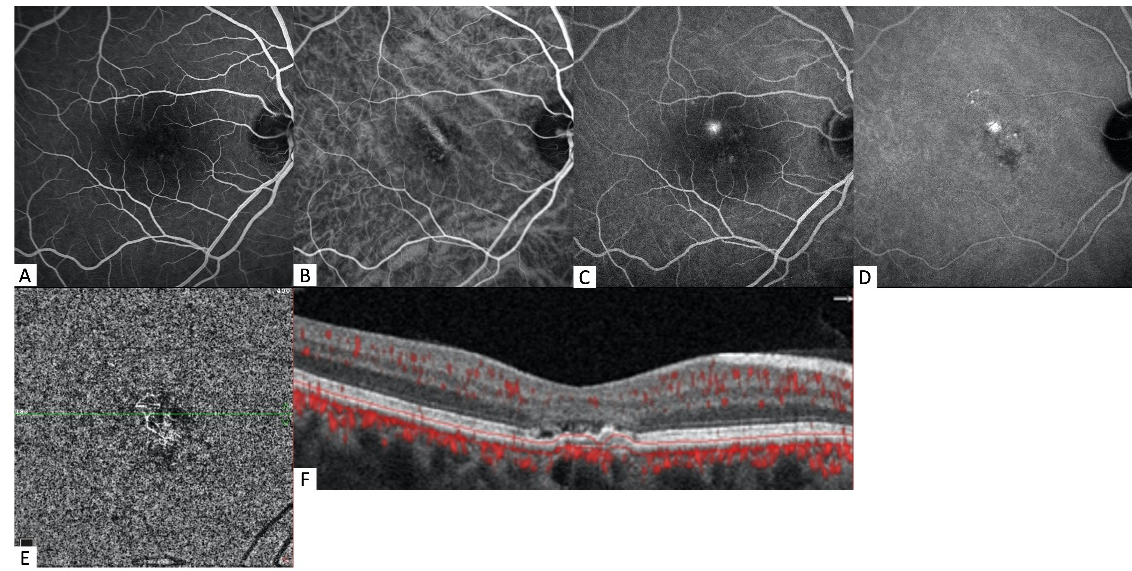
Figure 2. Multimodal images of a 44-year-old male patient. ( A ) The early phase of FA shows multiple small hyperfluorescent areas caused by retinal pigment epithelium alterations in the right eye. ( B ) The early phase of ICGA shows dilated choroidal vessels. ( C ) The late phase of FA reveals an undetermined source of late leakage. ( D ) The late phase in ICGA shows focal choroidal hyperpermeability areas corresponding to FA. ( E ) Choriocapillaris slab of OCTA detects a small trunk of the neovascular membrane with peripheral anastomosis. ( F ) The corresponding B-scans with flow overlay show flat irregular PED with minimal subretinal fluid.